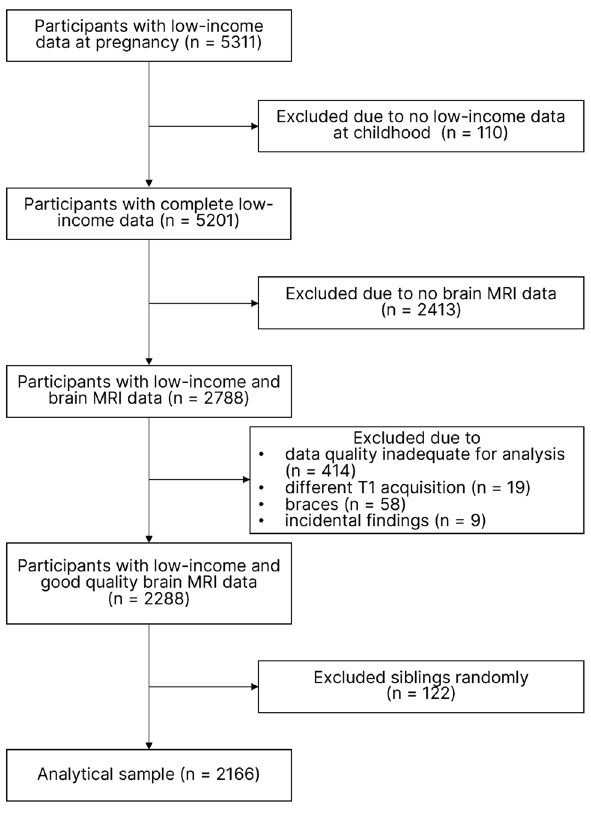
Figure 1. Sampling flow